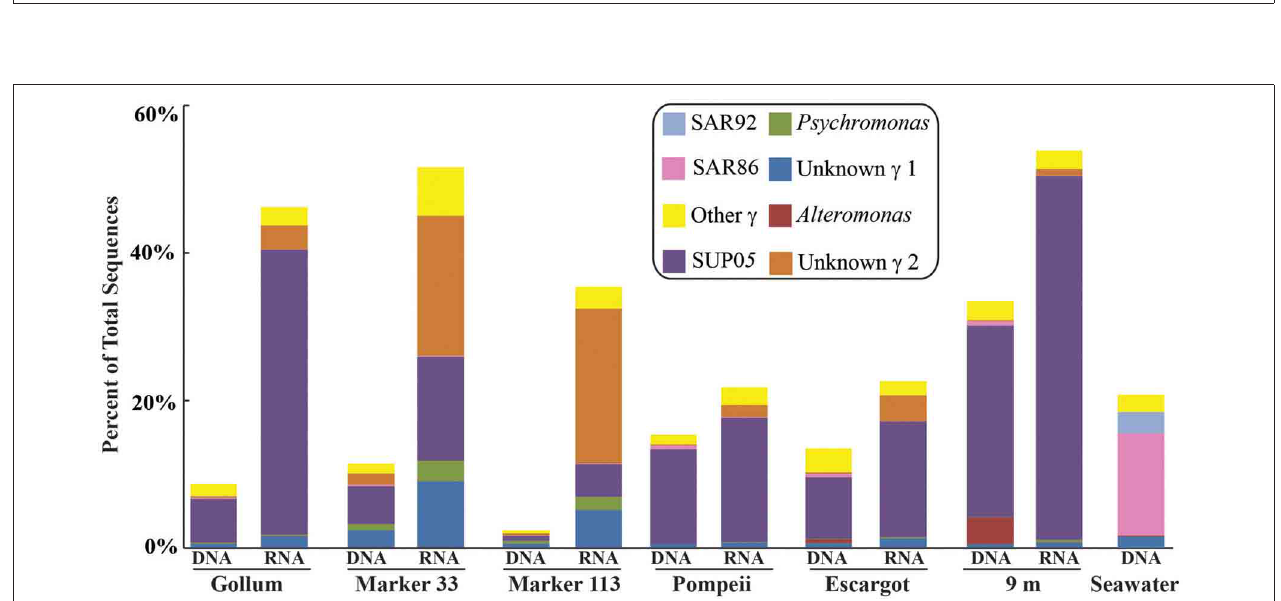
FIGURE 7 | Taxonomic breakdown and relative abundance of dominant Gammaproteobacteria at the genus level for 96% 16S rRNA gene OTUs in each sample. All other Gammaproteobacteria sequences are lumped into “Other.”